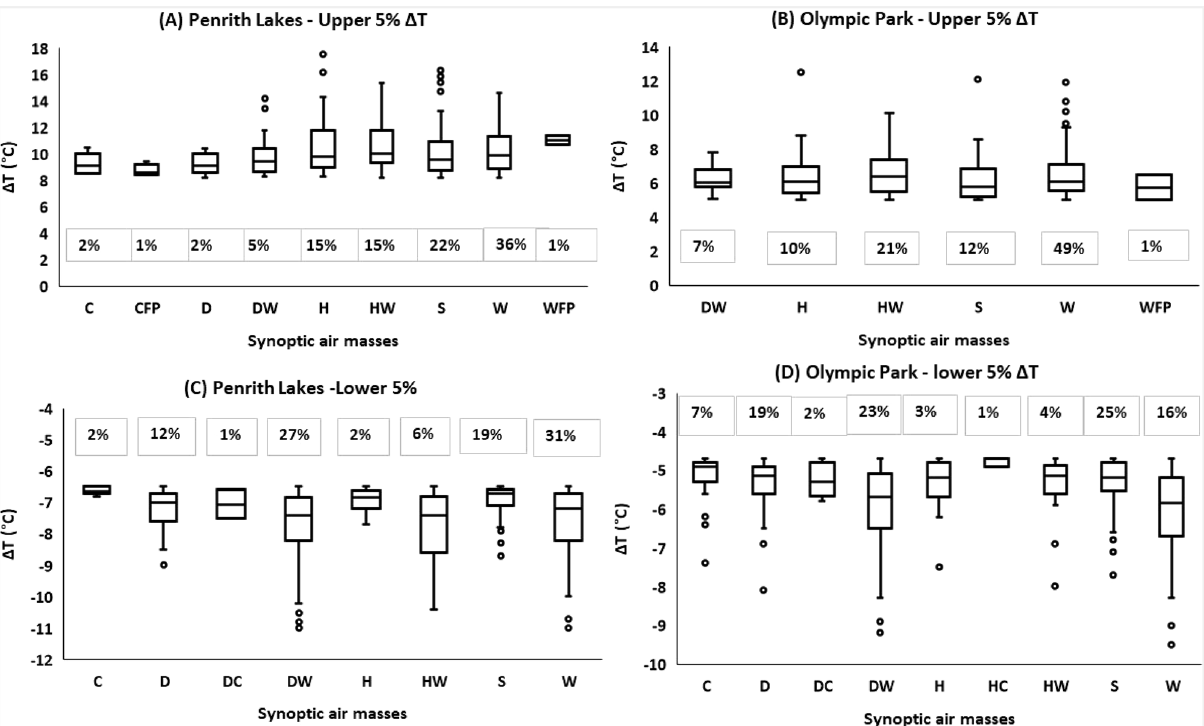
Figure 4. Higher 5% (UO) and lower 5% (UC) ΔT at different Sydney sites under different synoptic air- masses. (A) UO at Penrith Lakes, (B) UO at Olympic Park (C) UC at Penrith Lakes, (D) UC at Olympic Park. The boxplots are plotted according to the general convention (upper and lower extremes: Q1-1.5*IQR and Q3 +